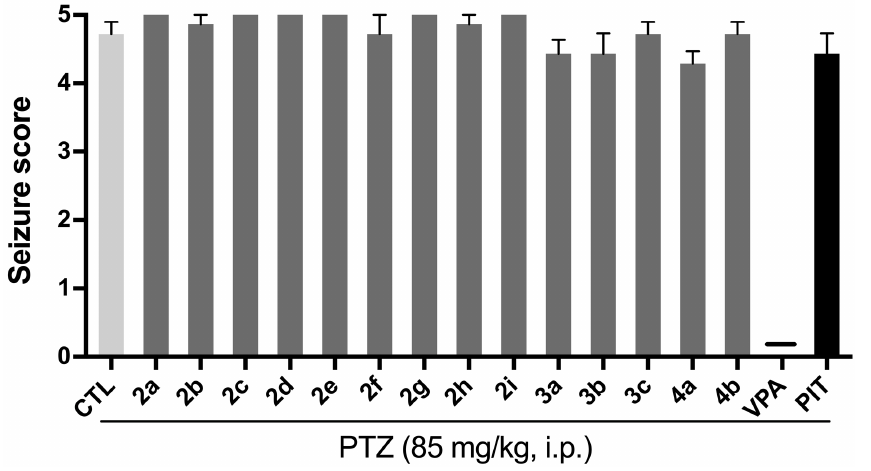
Figure 3. The performance of compounds 2a-2i , 3a-3c , and 4a-4b (10 mg/kg, i.p.), H 3 R antagonist PIT (10 mg/kg, i.p.), and antiepileptic VPA (300 mg/kg, i.p.) in the PTZ-induced seizure model. The seizure scores came from seven animals in each group and are shown as mean ± SEM in the figure. This represents that VPA fully inhibited the convulsive behavior induced by PTZ.